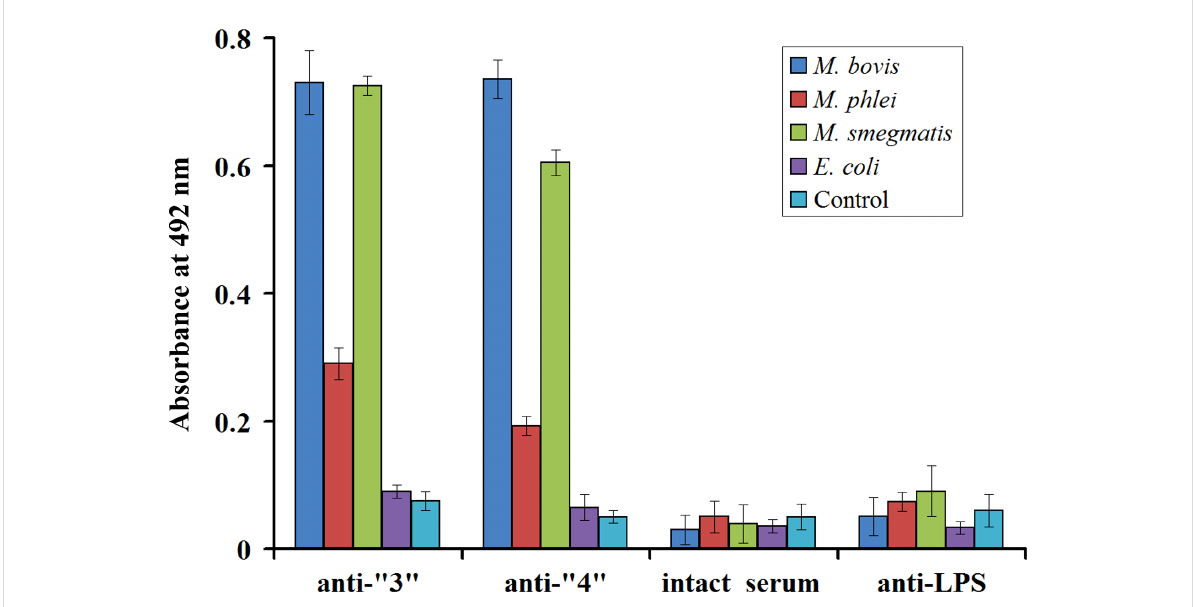
Figure 6: Results of ELISA of M. bovis , M. phlei , M. smegmatis and E. coli cell suspensions (10 8 cells·mL − 1 ) with antisera against Ara 6 C 2 NH 2 -GNPs 3 (anti-“ 3 ”), Ara 6 C 2 EG 7 NH 2 -GNPs 4 (anti-“ 4 ”), intact rabbit serum used for immunization or antibodies against LPS of Azospirillum brasilense Sp7 generated in the presence of CFA [99]. Error bars indicate the observed confidence intervals at p < 0.05. See also all titration curves in Figure S1 (Supporting Information File